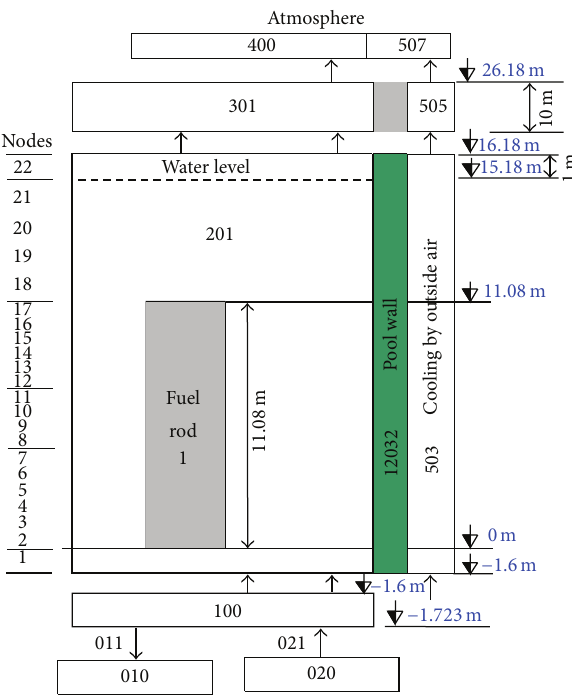
Figure 4: SFP and SFAs simplified nodalization scheme in RELAP/SCDAPSIM model.